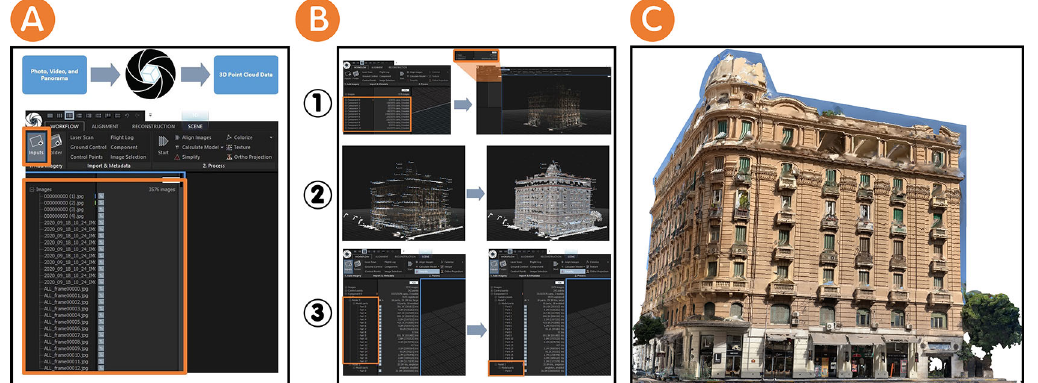
Figure 3. (A) Importing 2Ddata tothe RealityCapture platform and creating 3D pointclouddata asthe output of 2D data; (B-1) Aligning images processed through the RealityCapture platform to form 3D point cloud data